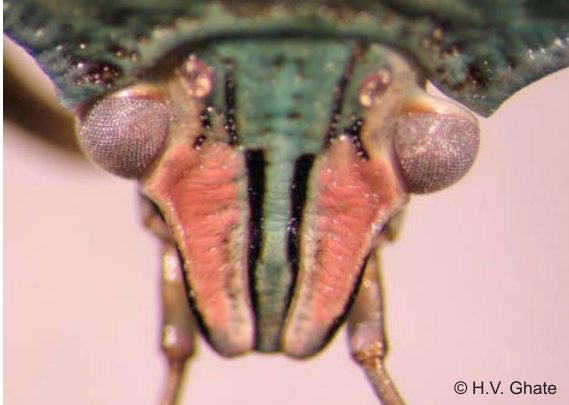
lobe, by black lines